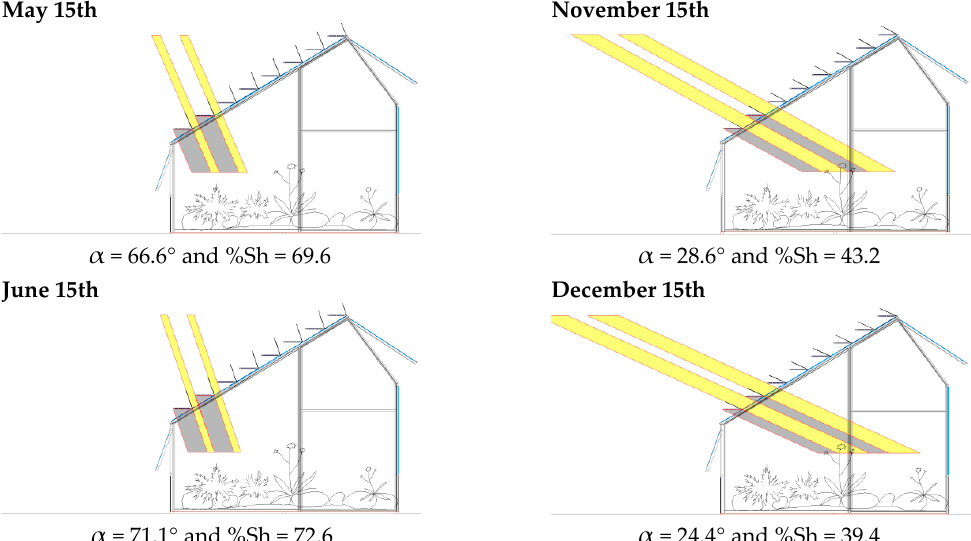
Figure 5. The elevation angle of the sun’s rays and the percentage shading (%Sh) with the fixed horizontal panels at a latitude of 42.2° North and calculated on the 15th day of each month.